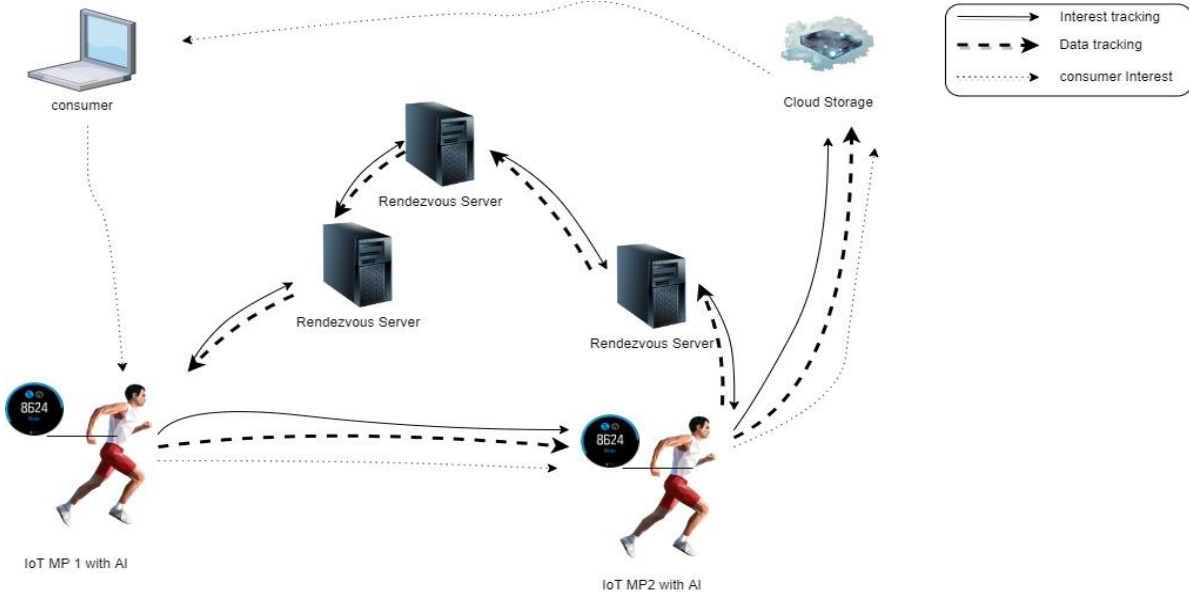
Figure 6. The PMSS with cloud operation. Table 3. The PMSS ’s operation.